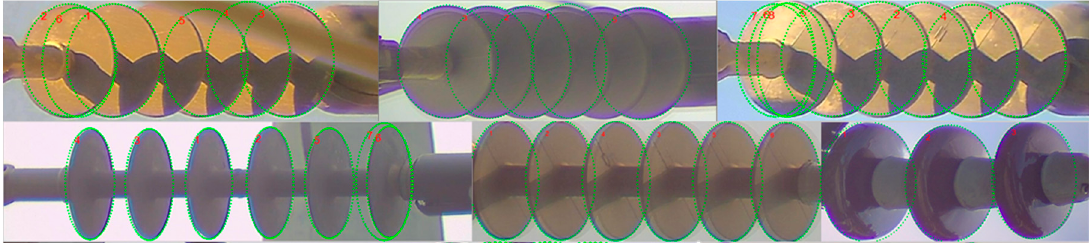
Figure 11. Ellipse detection results on different types of insulators. Ellipses with the highest detection confidence are numbered in ascending order, represented with red color.